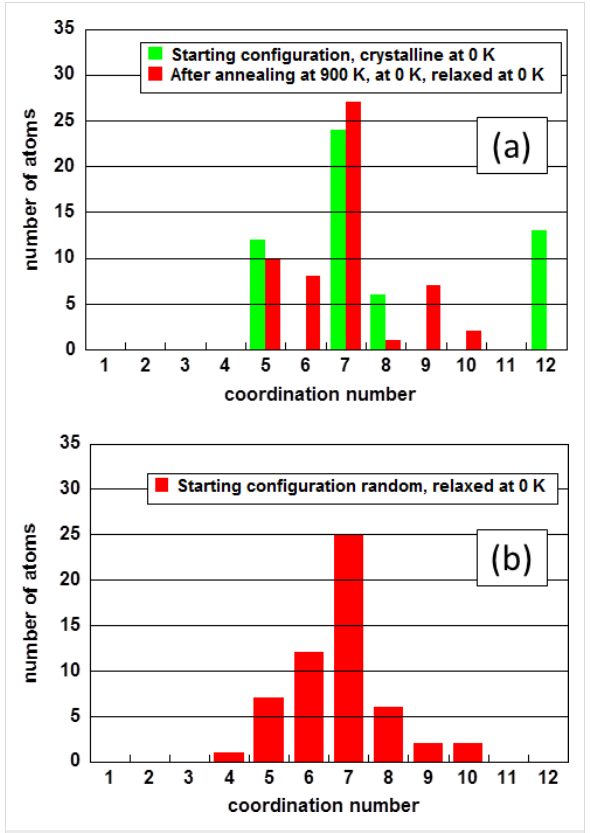
Figure 1: Histograms of the coordination numbers for the two starting configurations crystalline and random. (a) Coordination numbers of the initial crystalline cluster and after annealing at 900 K and relaxation at 0 K. (b) Coordination numbers of the originally random arrangement after relaxation at 0 K.